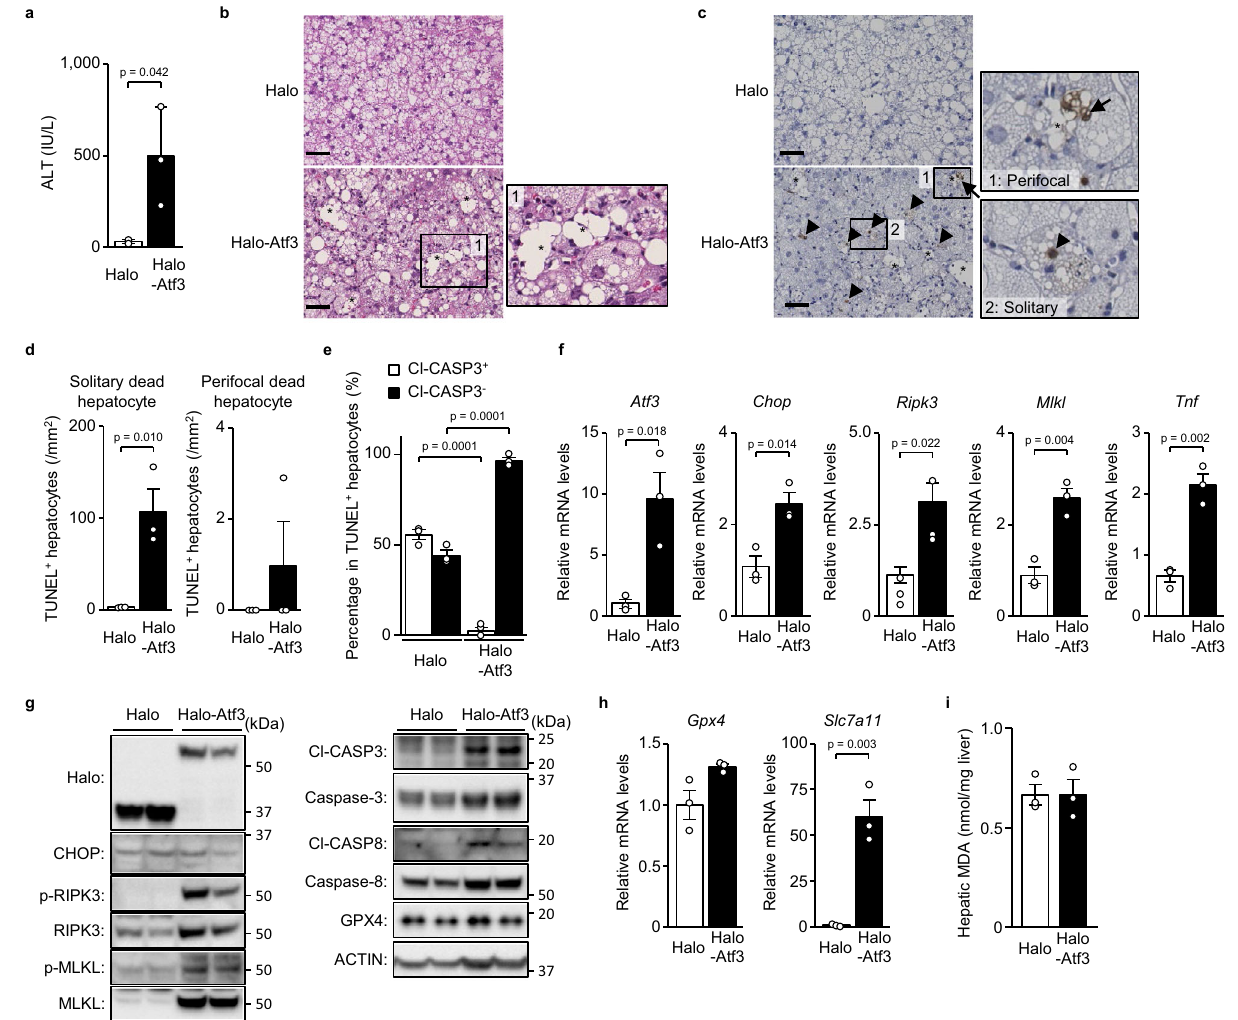
Fig.4|Atf3overexpressionincreasesnecroptosisinun-hepatectomisedsevere steatosis. Halo-Atf3orhalowasoverexpressedbyadenovirusinmicefedaHFDfor 16 weeks. a Plasma ALT levels. b Haematoxylin-eosin staining. Scale bar, 50 μ m. Asterisks indicate hepatocellular death foci. c TUNEL staining. Scale bar, 50 μ m. Arrowheads indicate solitary dead hepatocytes. Asterisks indicate hepatocellular death foci. Arrows indicate perifocal dead hepatocytes. d Number of TUNEL